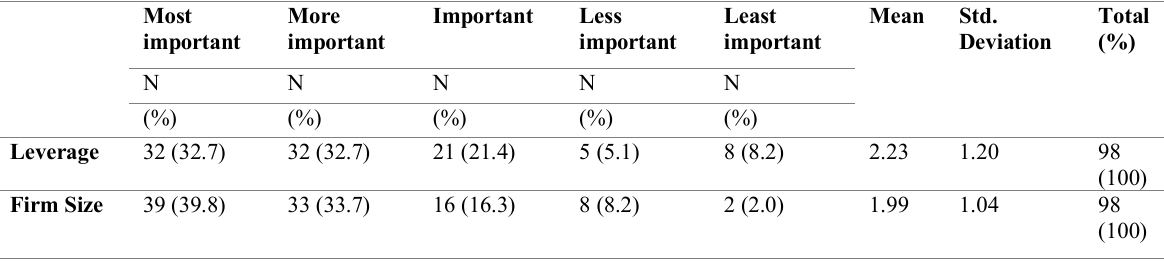
Table 2: Impact of capital determinants on financial performance